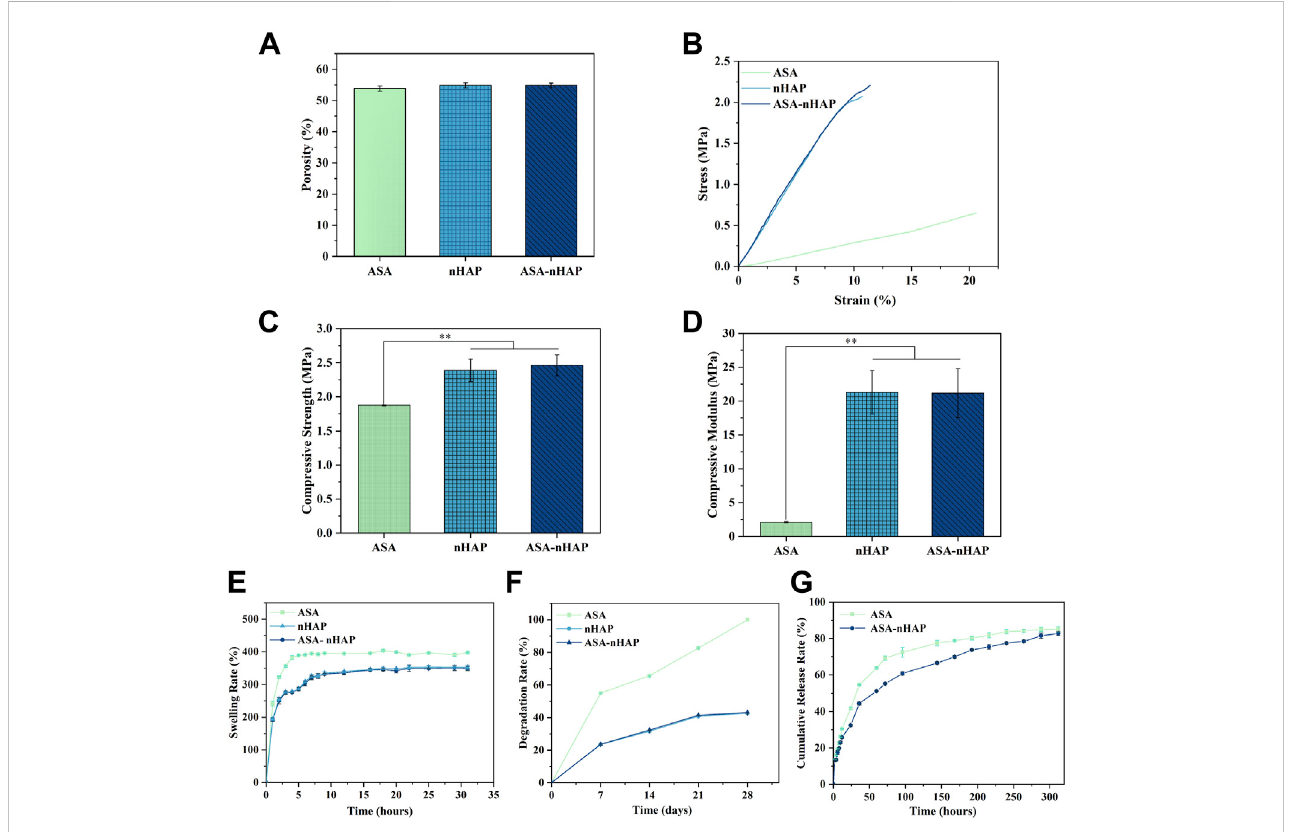
FIGURE 3 Characterization of hydrogel scaffolds. (A) The porosity of hydrogel scaffolds. (B) The stress-strain curve of hydrogel scaffold. (C) The compressive strength of hydrogel scaffold. (D) The compressive modulus of hydrogel scaffold. (E) The swelling performance of hydrogel scaffolds. (F) The degradation performance of hydrogel scaffolds. (G) The drug release performance of hydrogel scaffolds. (** p <